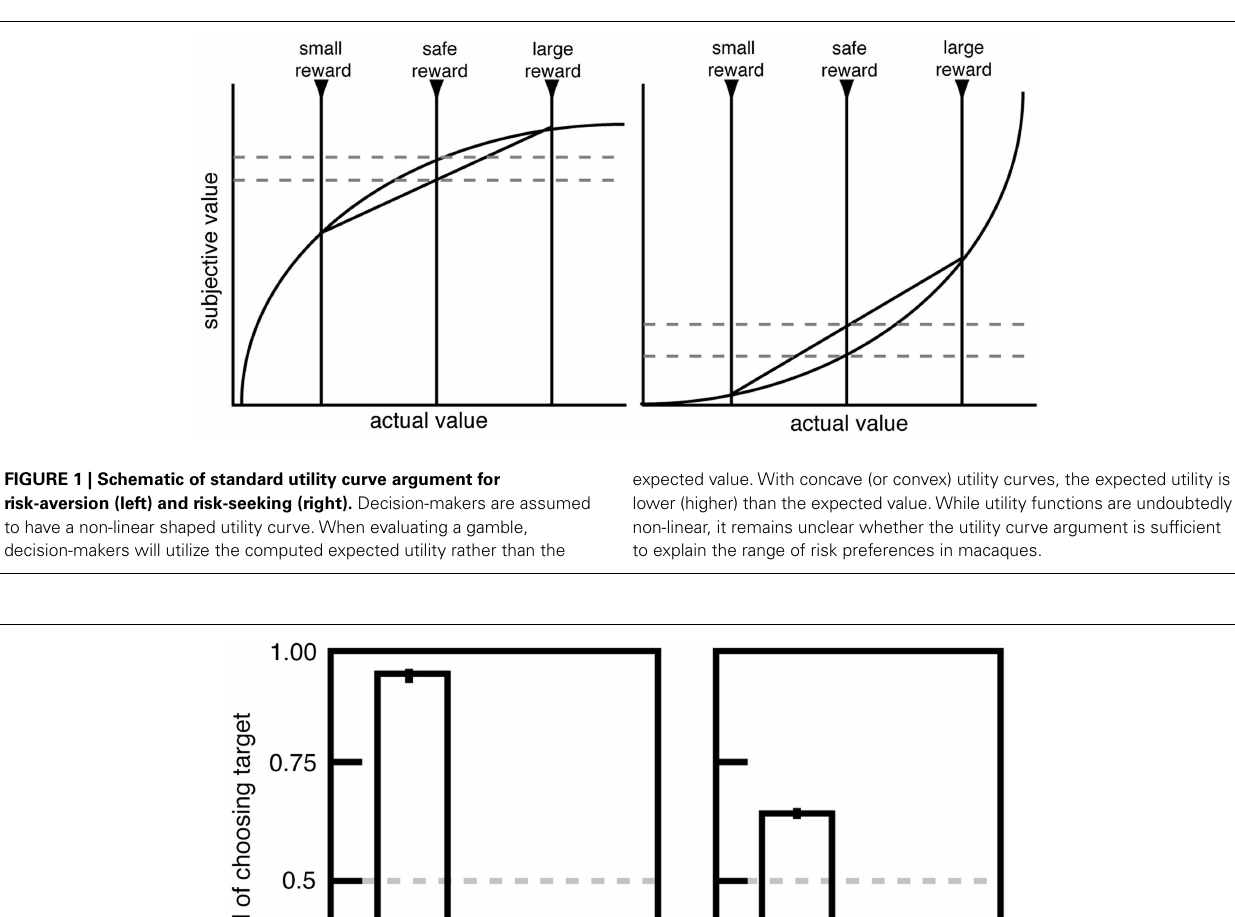
FIGURE 2 | Preferences for risky options over alternating ones are inconsistent with the standard utility curve argument . Left: plot of preferences for risky (unpredictable) and alternating (predictable) options offering the same pairs of outcomes. Right: plot of preferences for alternating (predictable) and safe (fixed) options. Adapted from Hayden et al.